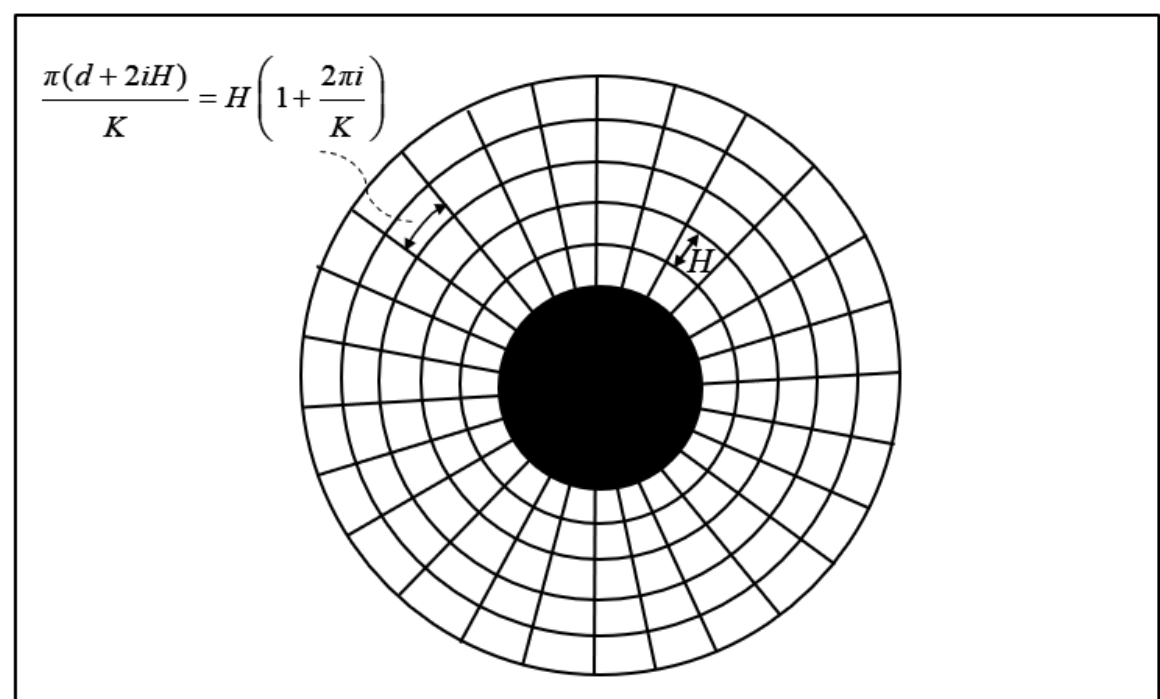
Figure 1. Dimensions of the cross-section.